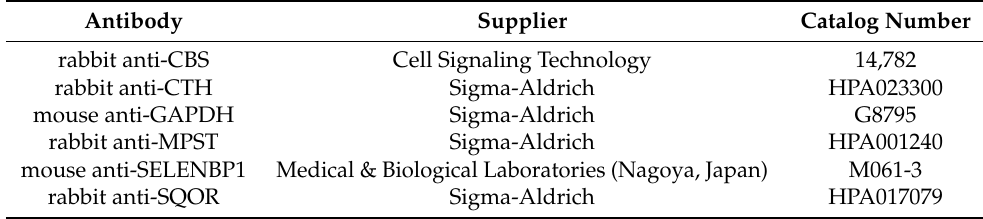
Table 2. Primary antibodies used for immunoblot